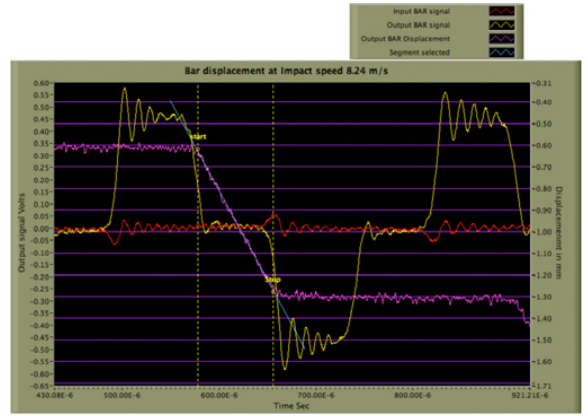
Fig. 9. Output bar displacement and wave